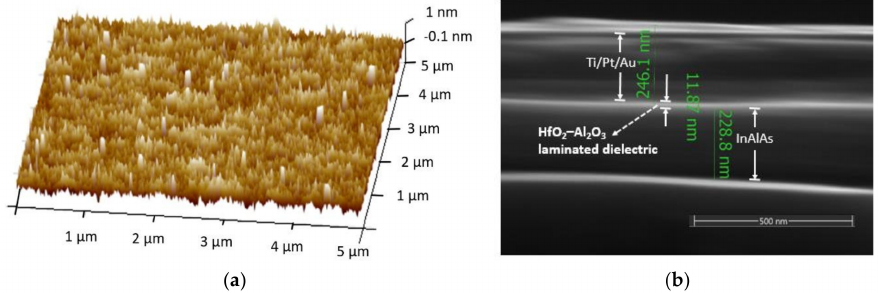
Figure 2. ( a ) AFM graph of the HfO 2 (4 nm)/Al 2 O 3 (8 nm) MOS capacitor; ( b ) FIB-SEM image of the